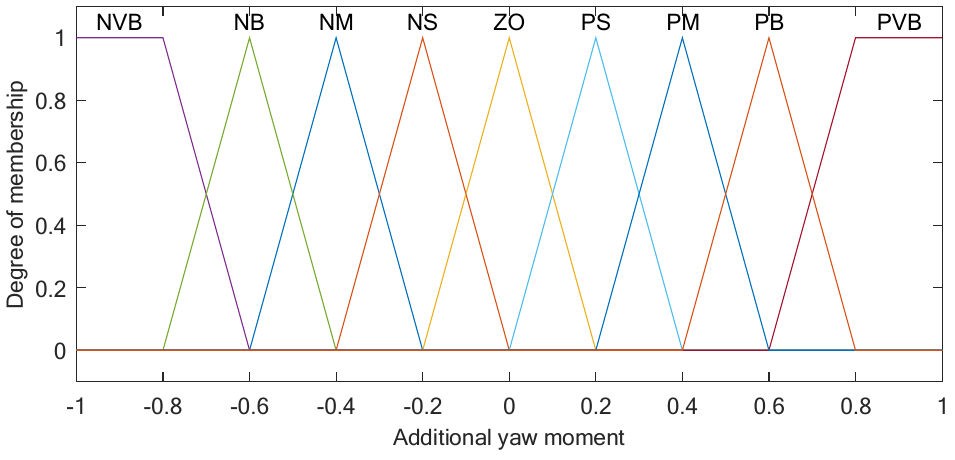
Figure 9. Membership function of the sideslip angle deviation